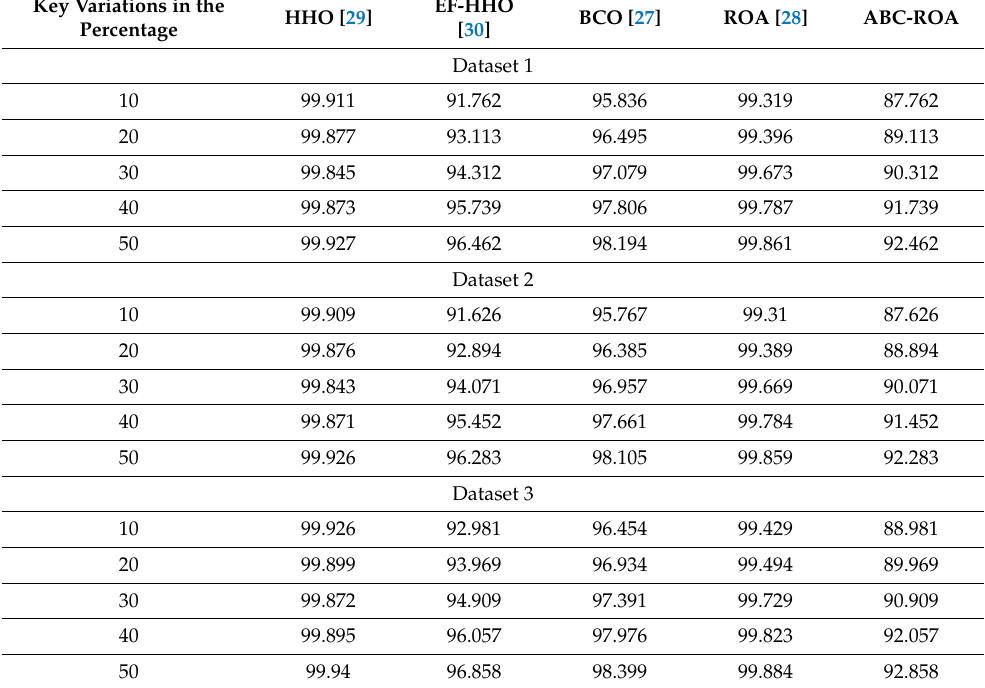
Table 2. Effectiveness analysis using CCA with three datasets for the developed blockchain-based data privacy preservation system over Ethereum network.